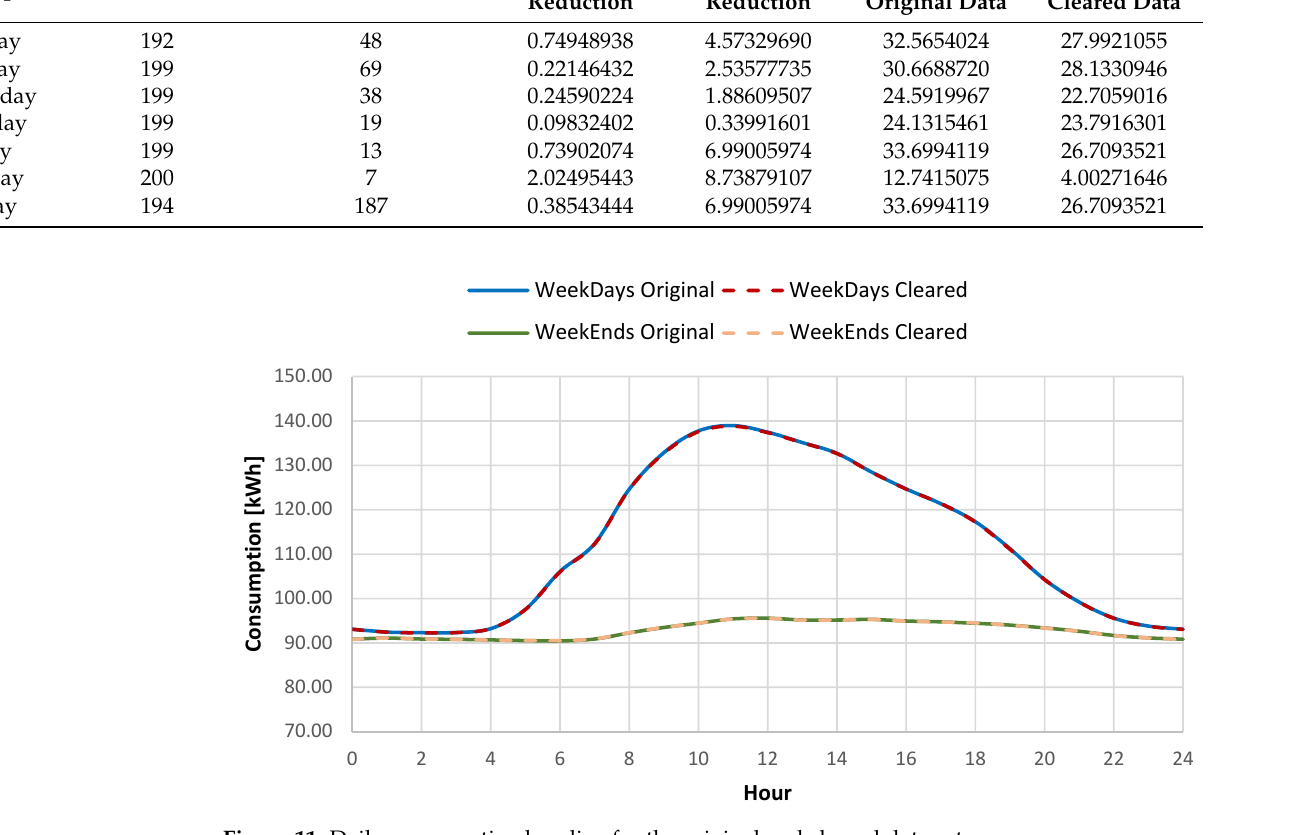
Table 9. Full year baseline for original and cleared data sets.